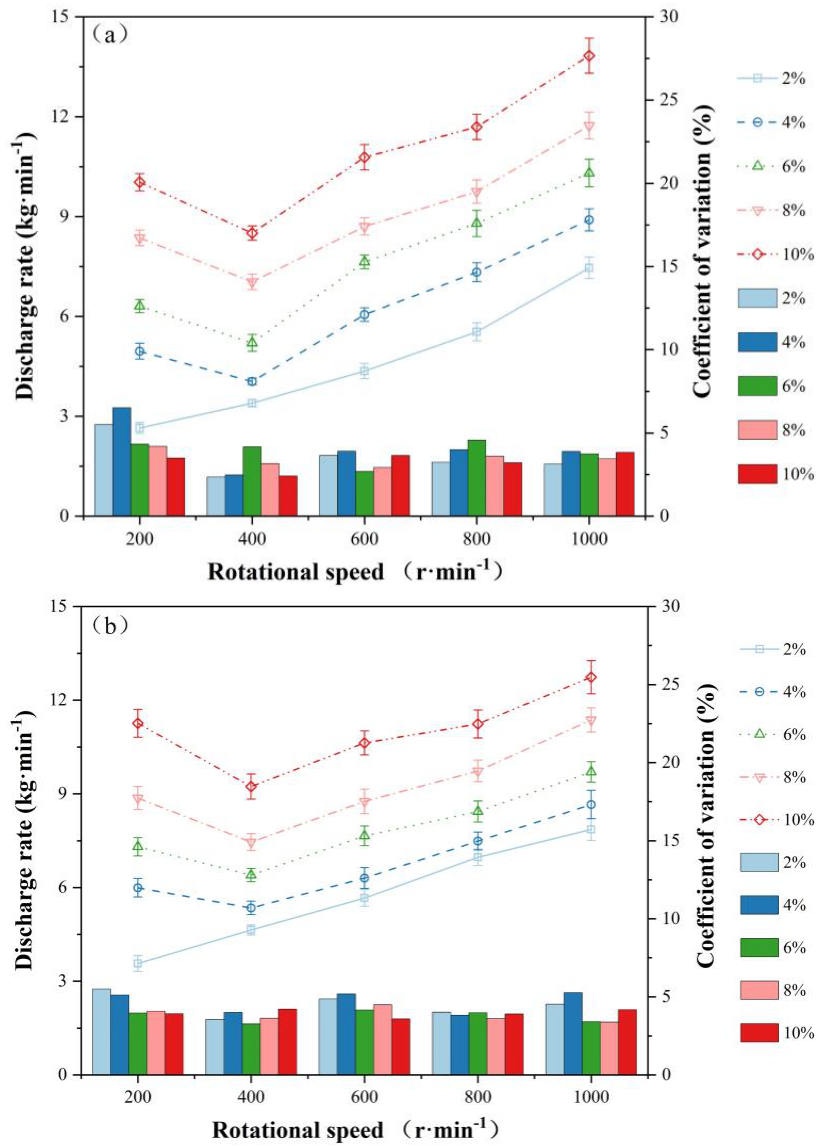
Figure 11. Displacement at different speeds. ( a ) Compound fertilizer. ( b ) Urea.